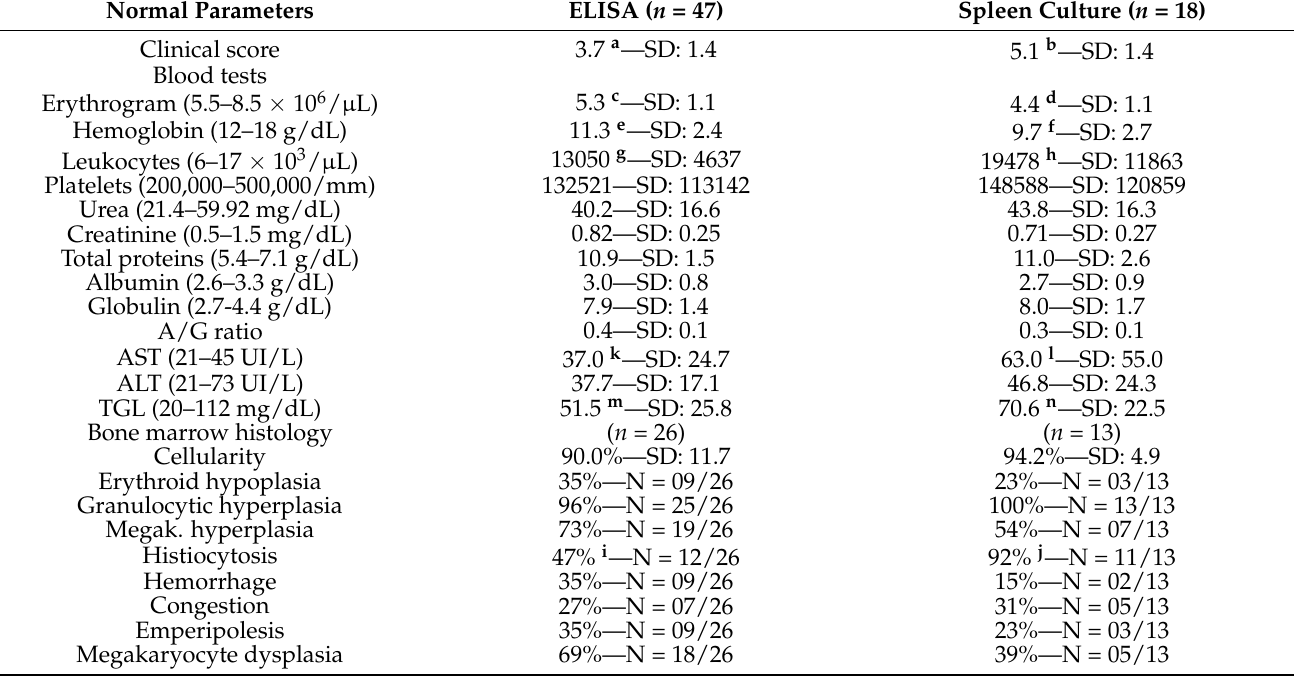
Table 2. General results of the different tests detecting L. infantum infection in semidomiciled dogs. Normal